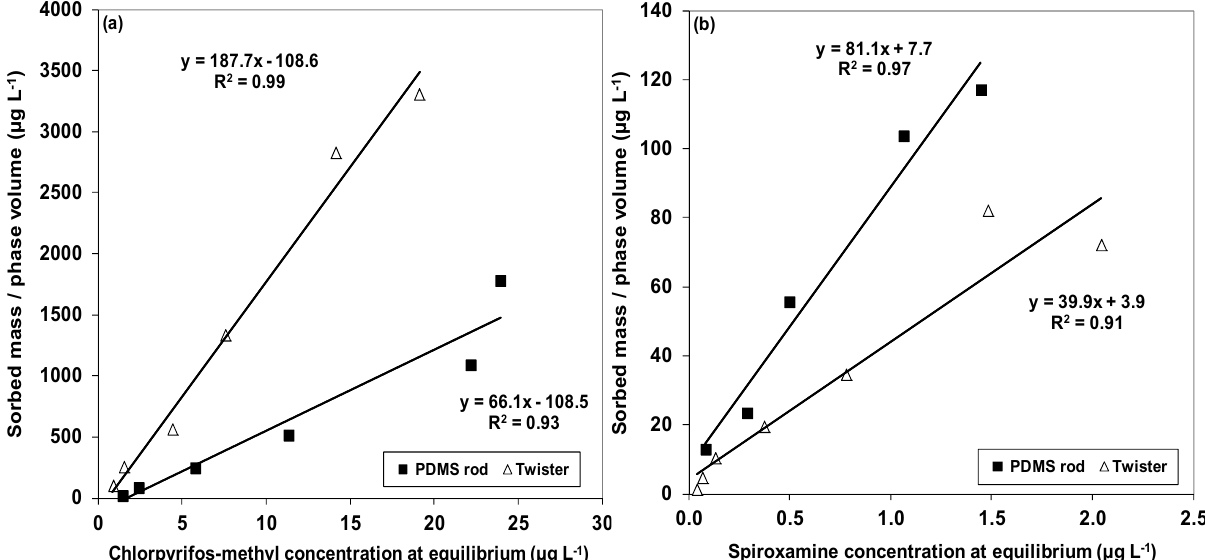
Figure 2. Sorption isotherms of ( a ) chlorpyrifos-methyl and ( b ) spiroxamine on PDMS rods (phase volume = 180 μ L) and Twisters (phase volume = 126 μ L). Extraction at 700 rpm for 5